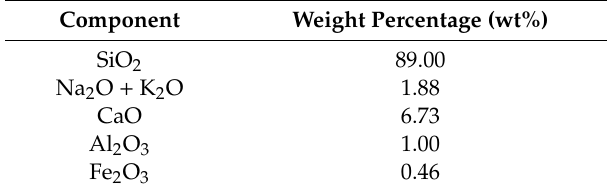
Table 1. Composition of diatomaceous earth used in PLA / DE composites.